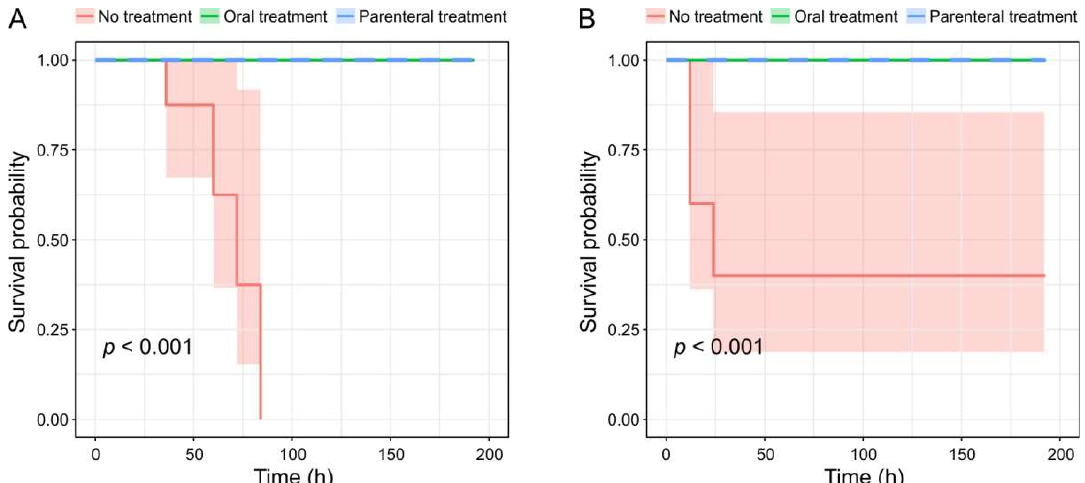
Figure 6. Survival curves in the animal infection model experiment. ( A ) Mice infected with E. faecalis strain CCUG 52538 and treated with the phage GVEsP-1. ( B ) Mice infected with E. faecalis strain Serg and treated with the phage SSsP-1.